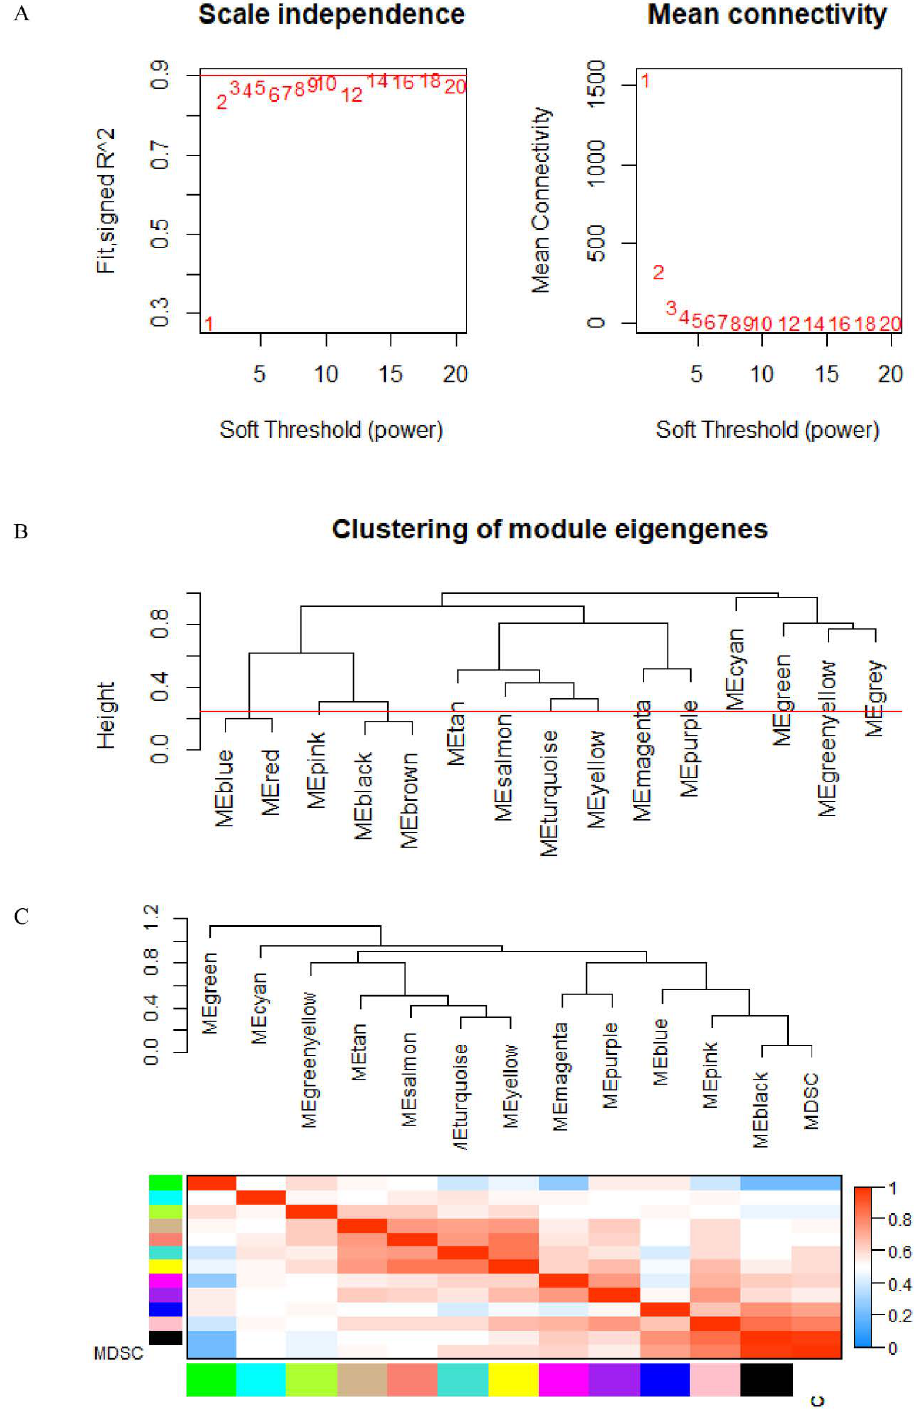
Figure 3. ( A ) Analysis of weighted gene co-expression networks: determination of soft-threshold power. ( B , C ) Dendrogram of consensus module eigengenes.